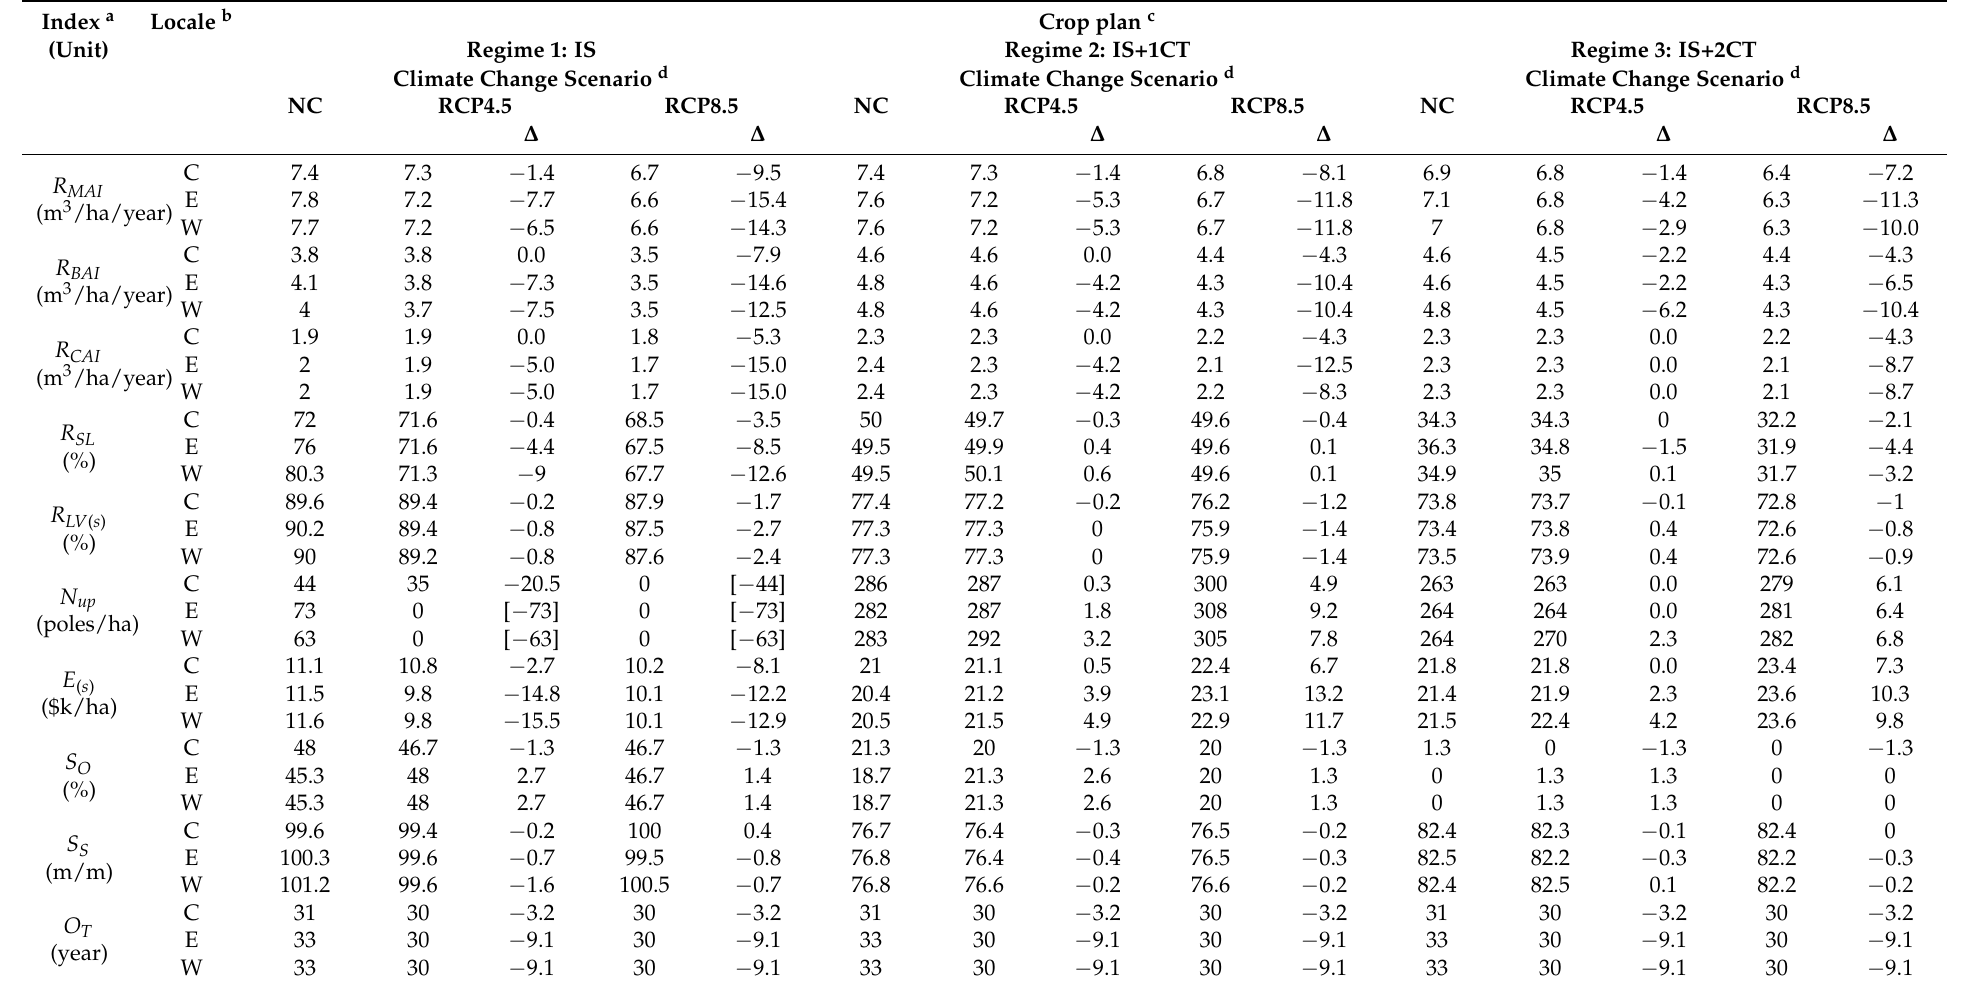
Table 5. SSDMM-derived rotational stand-level performance indices for three crop plans growing under three climate change scenarios for red pine plantations situated in north-central (Thessalon), north-eastern (Kirkland Lake) and north-western (Thunder Bay)